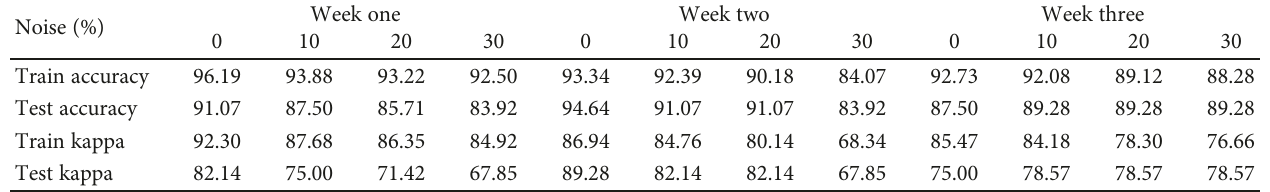
Table 2: oRF-RR classi fi cation accuracies for three simulated noise levels for three weeks of infestation. Noise